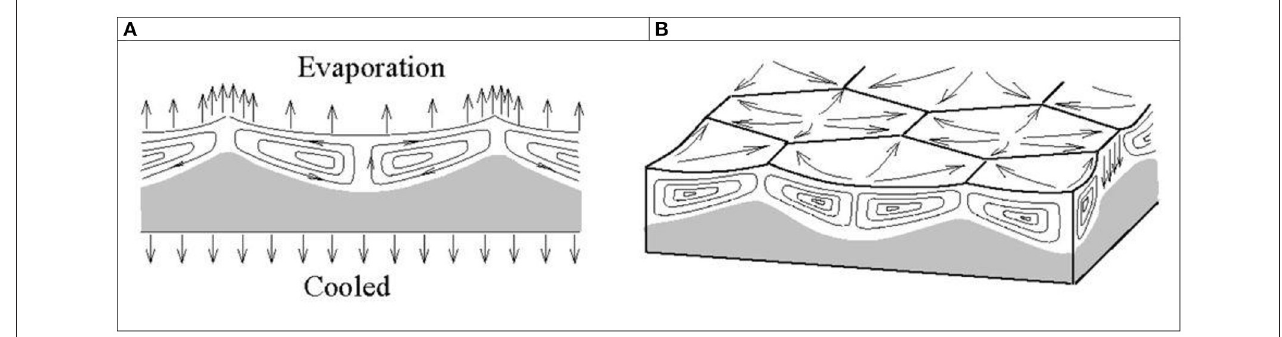
FIGURE 8 | Temperature gradient circulating flow in an evaporating liquid layer cooled: (A) circulating flow induced by evaporation; (B) tessellation on the layer surface (Zhang, 2006).